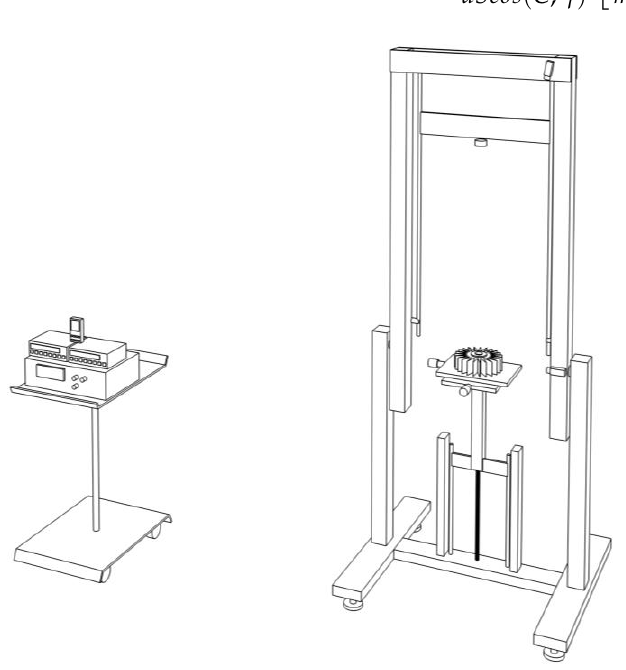
Figure 1. The set-up for indirect luminance measurement.